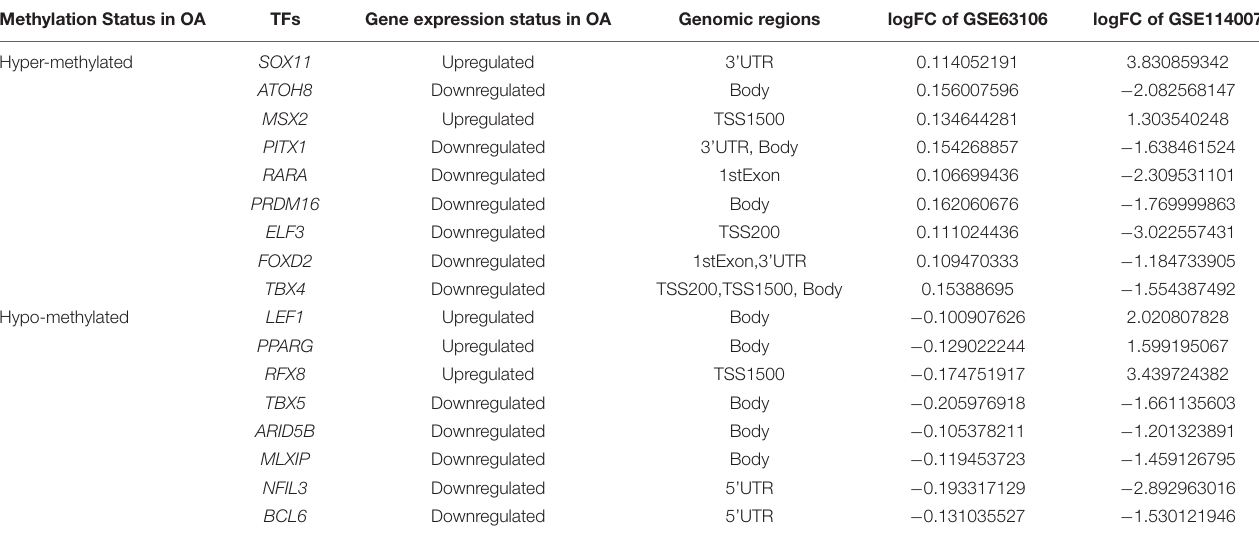
TABLE 3 | DETFs harboring DMS in knee articular cartilage from normal and OA